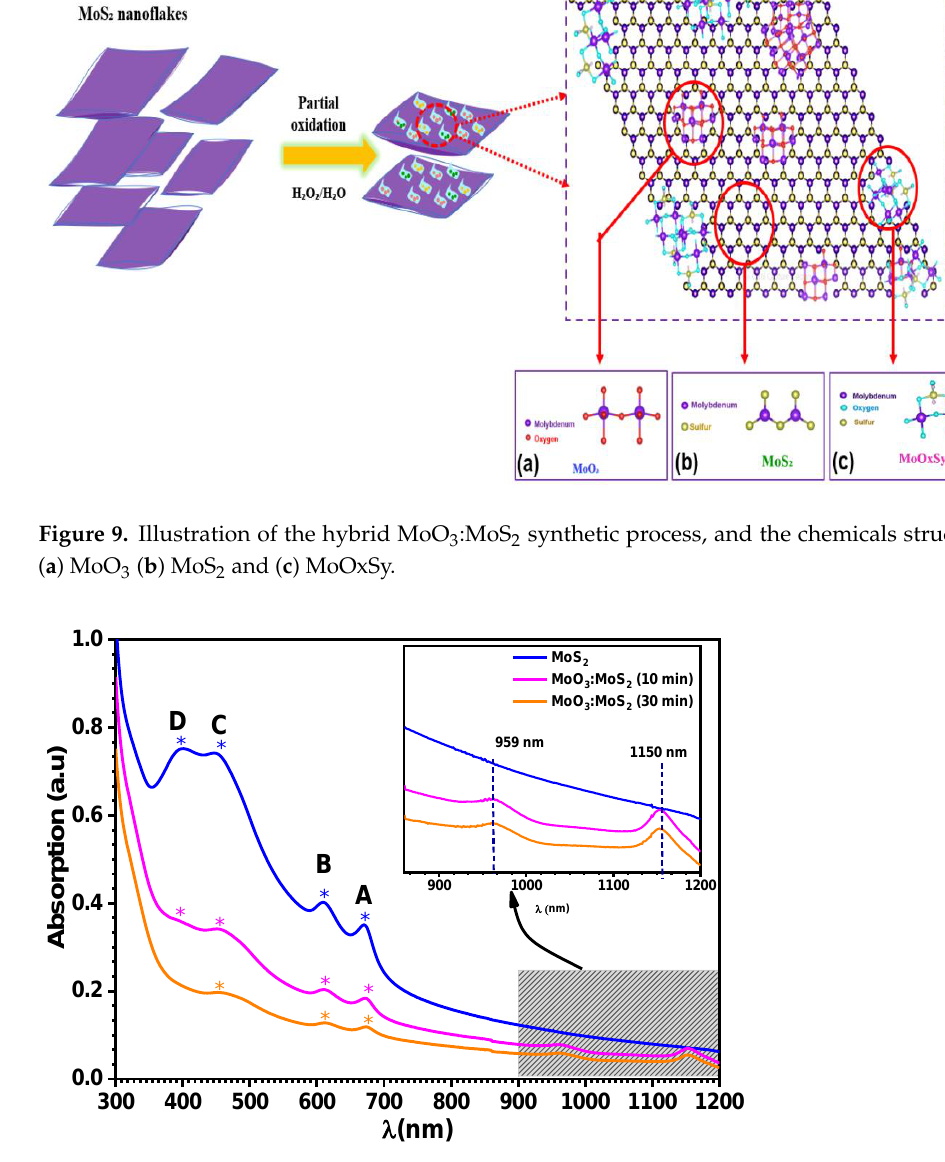
Figure 9 . Illustration of the hybrid MoO 3 :MoS 2 synthetic process, and the chemicals structure of (a) MoO 3 (b) MoS 2 and (c) MoOxSy